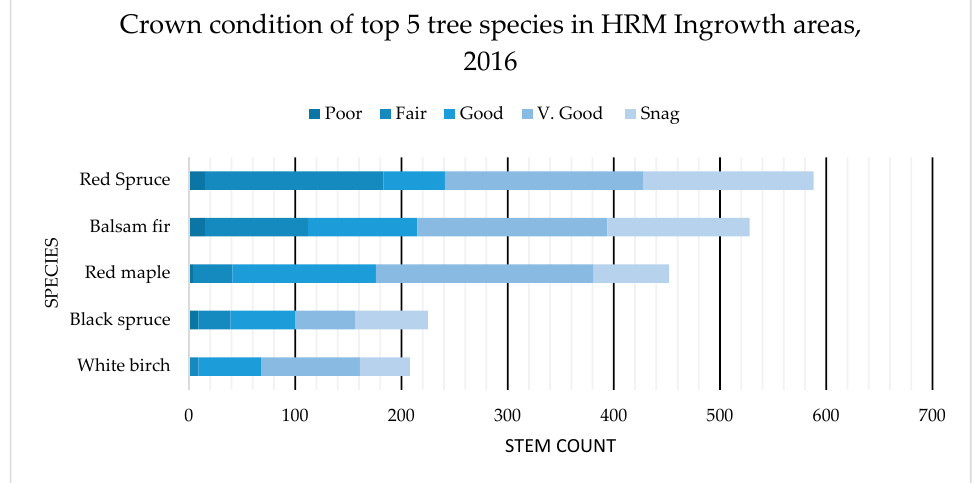
Figure 11. Canopy condition of the top five measured species found on OAGC in 2017, showing the significant impact of pests and disease on American beech.